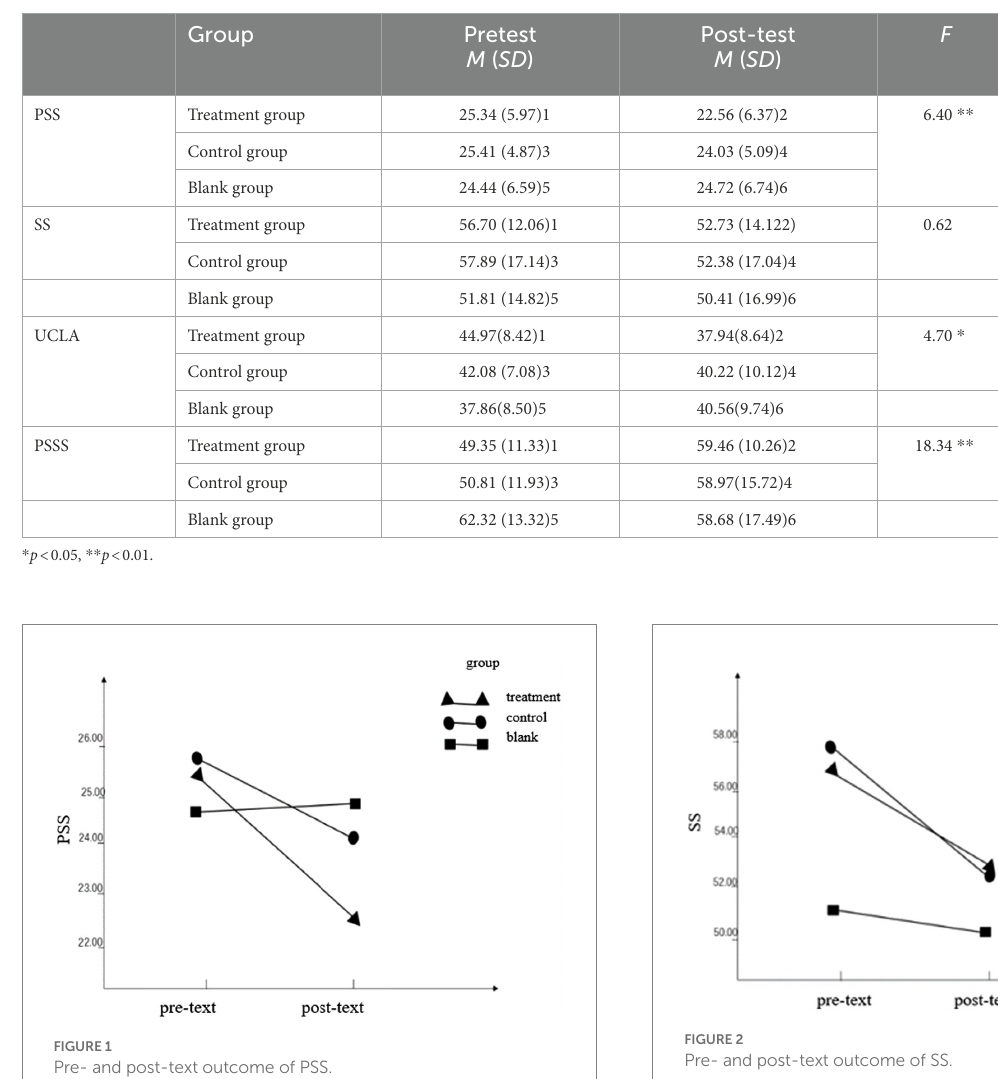
TABLE 2 Pre- and post-test outcomes.